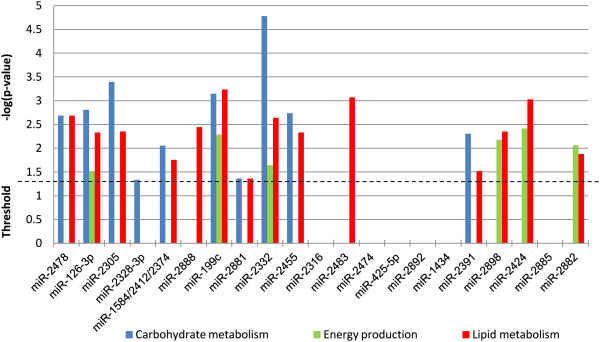
Association of predicted targets from bovine specific miRNAs to energy production, carbohydrate, or lipid metabolism. The likelihood of the association between the genes and a biological function is represented as –log(p-value), with larger bars being more significant than shorter bars. The vertical line indicates the cutoff for significance (p-value of 0.05). AT core miRNAs consist of miRNAs detected in the subcutaneous adipose tissue of all steers.